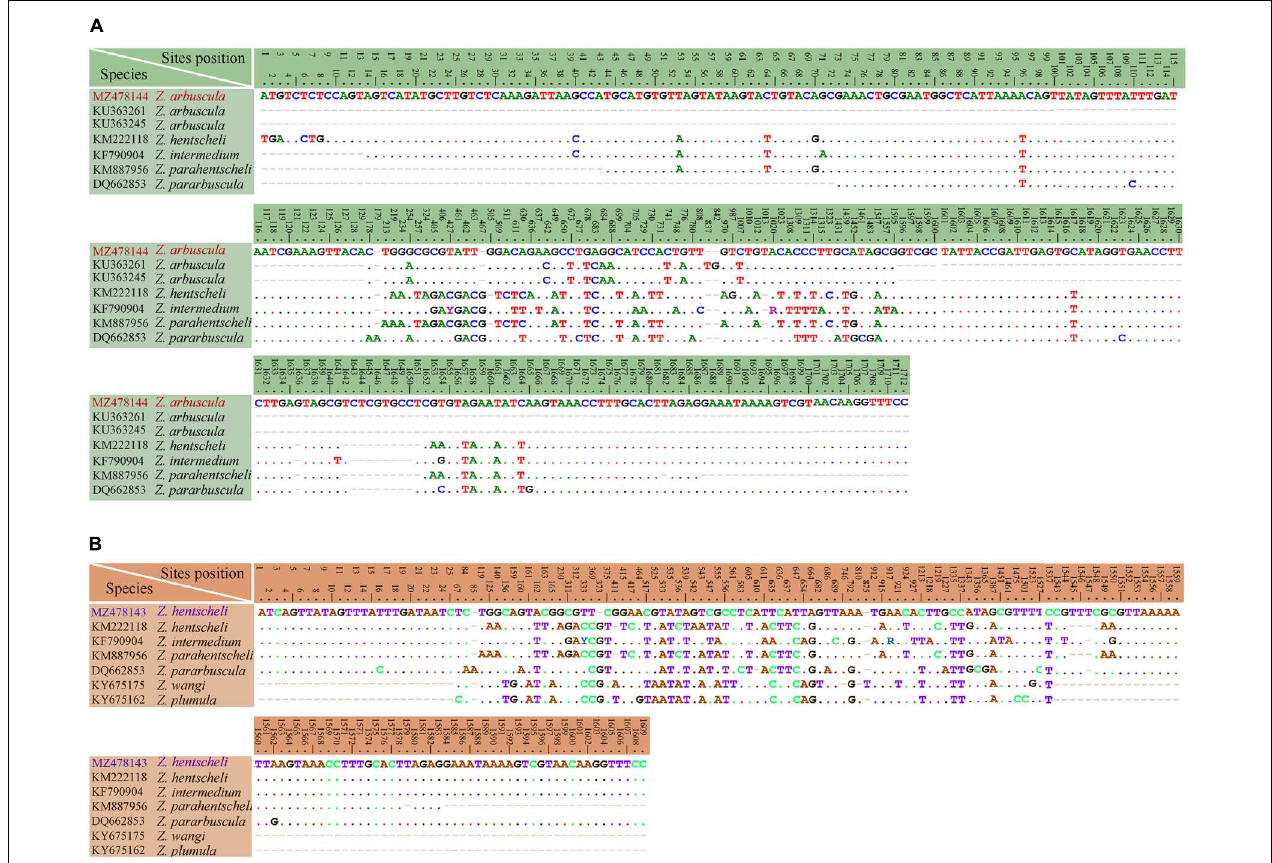
FIGURE 13 | Table of nucleotide variations based on SSU rDNA sequences. The numbers in the header indicate the unmatched site positions. (A) Zoothamnium arbuscula (Weishan population) with other populations and similar congeners. (B) Zoothamnium hentscheli (Weishan population) with another population and similar